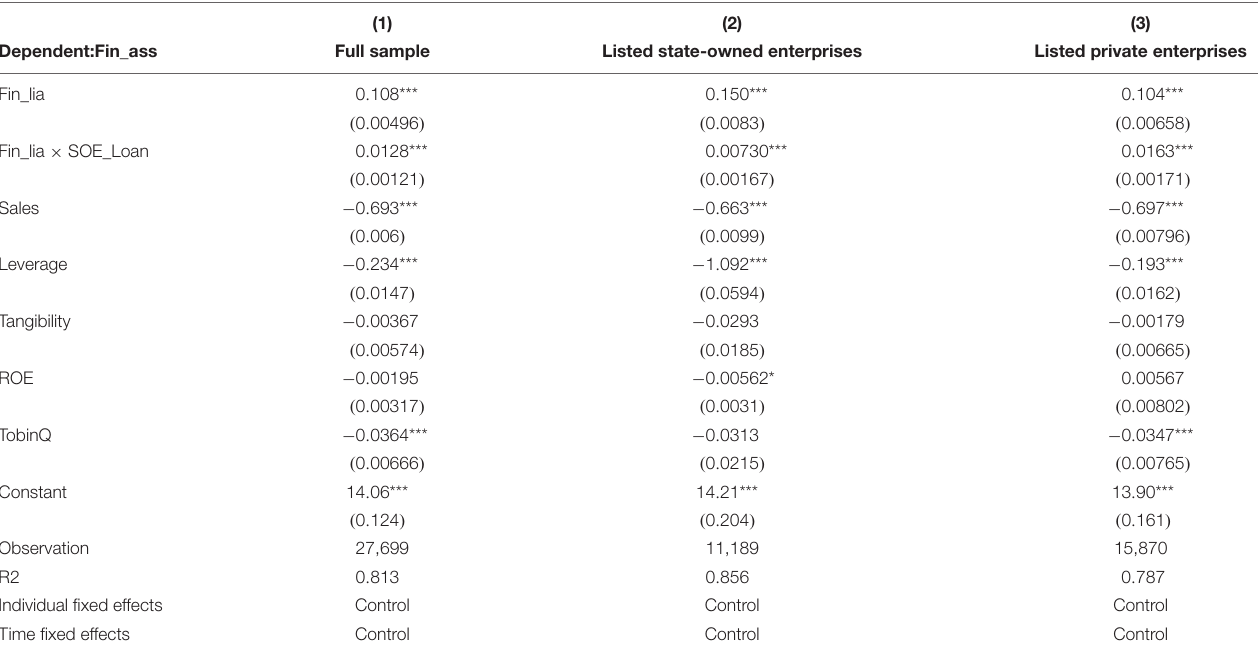
TABLE 9 | The proportion of state-owned enterprise loans and the “Borrow to Lend” activities of